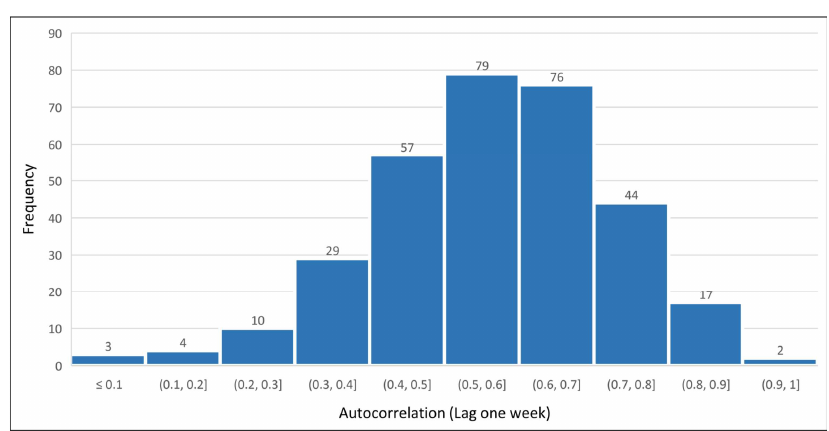
Figure 4. Autocorrelation frequency distribution over Period